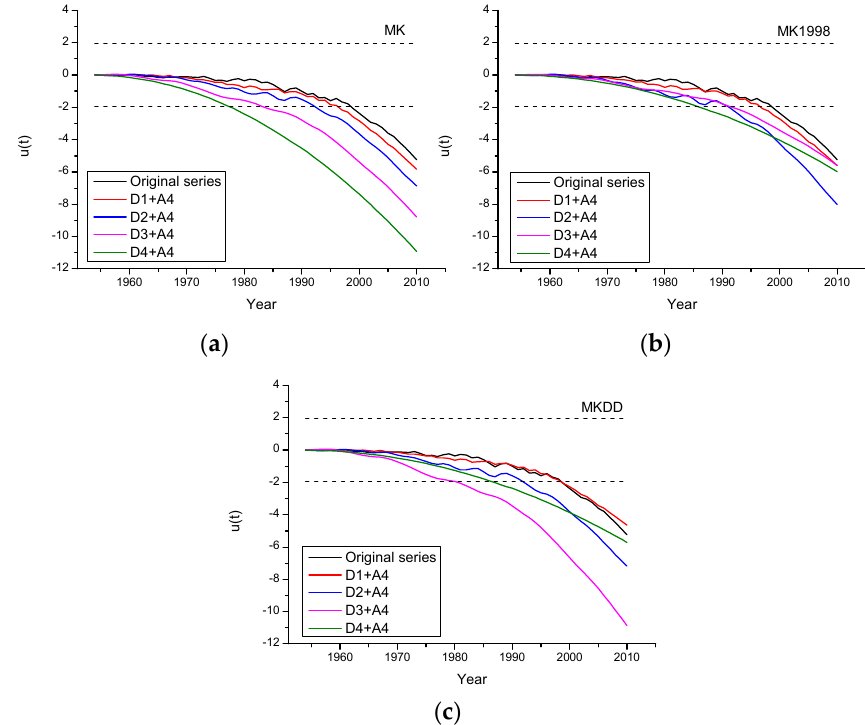
Figure 16. Three sequential Mann-Kendall graphs of annual mean streamflow series exhibiting the progressive trend lines of each detail component (with the addition of the approximation) with respect to the original series. The upper and lower dashed lines represent the confidence limits ( α = 5%). ( a ) MK; ( b ) MK1998; ( c ) MKDD.